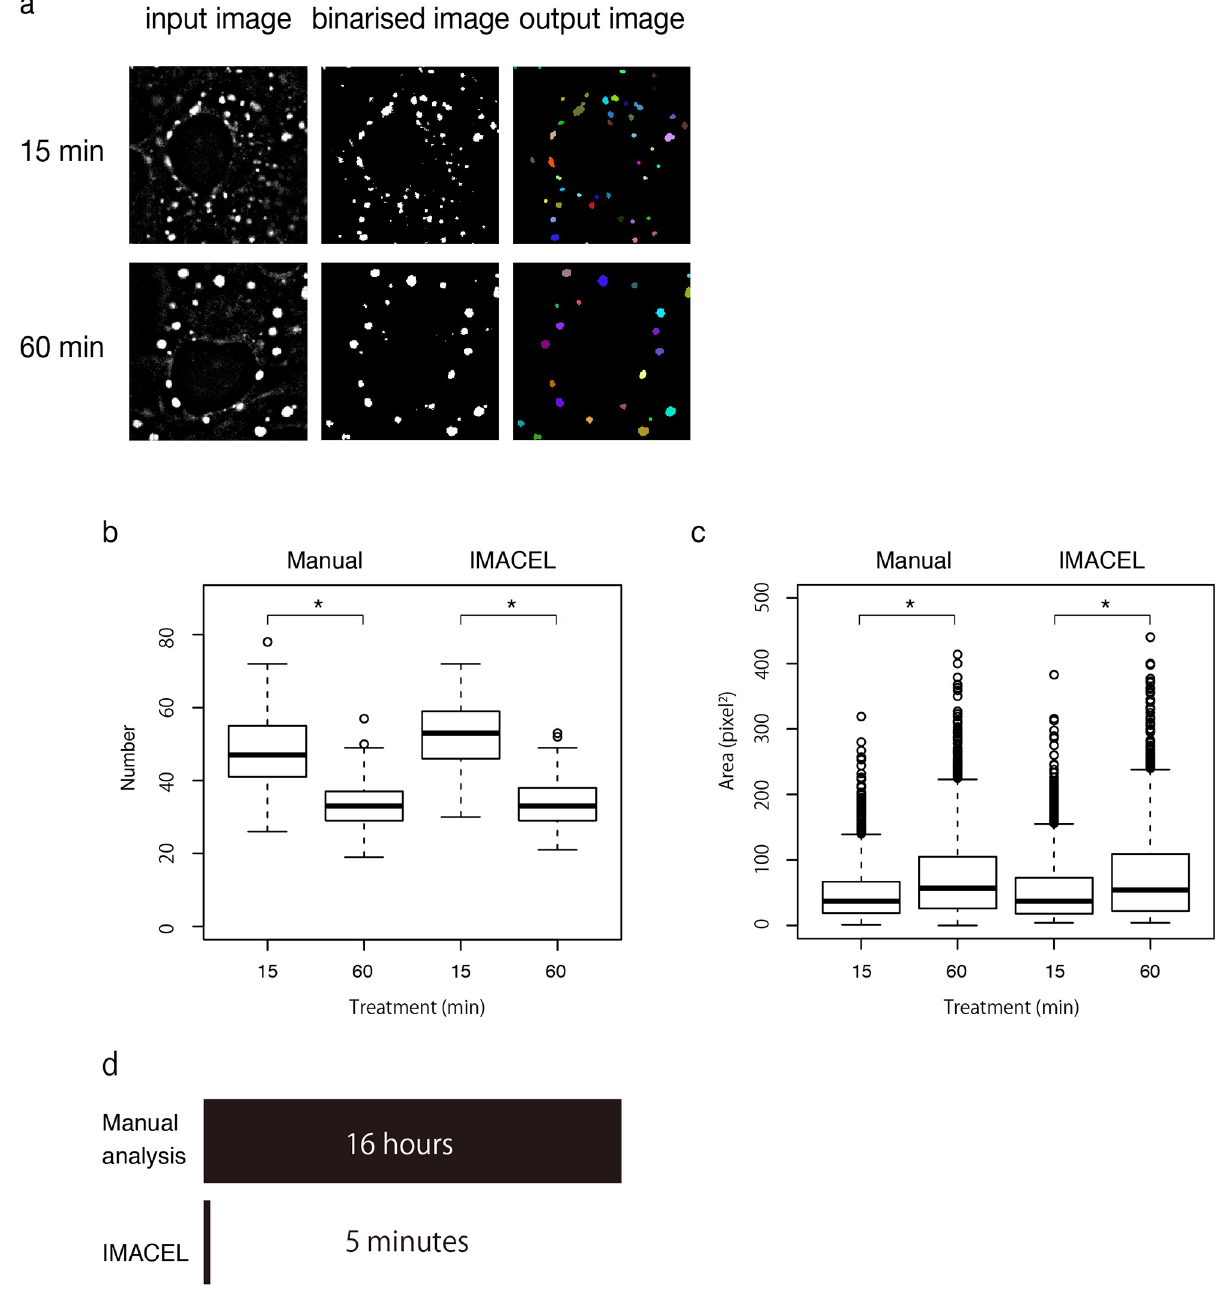
Fig 2. Results of the IMACEL particle analyser for extracting and evaluating stress granules in COS7 cells. (a) Input image, binarised image, and output image of the IMACEL particle analyser. Comparison of the distribution of the number (b) and size (c) of stress granules against stress treating time evaluated using manual evaluation and IMACEL. Asterisks indicate significant differences (Mann–Whitney U test) between cells treated with 0.5 μ M sodium arsenite for 15 min and 60 min (in number: p = 2.568 × 10 − 13 and p < 2.2 × 10 − 16 , in size: p < 2.2 × 10 − 16 and p < 2.2 × 10 − 16 ). (d) Total time spent on manual analysis versus the computational time of the IMACEL particle analyser. We measured 65 images each for specimen treated for 15 min and 60 min.